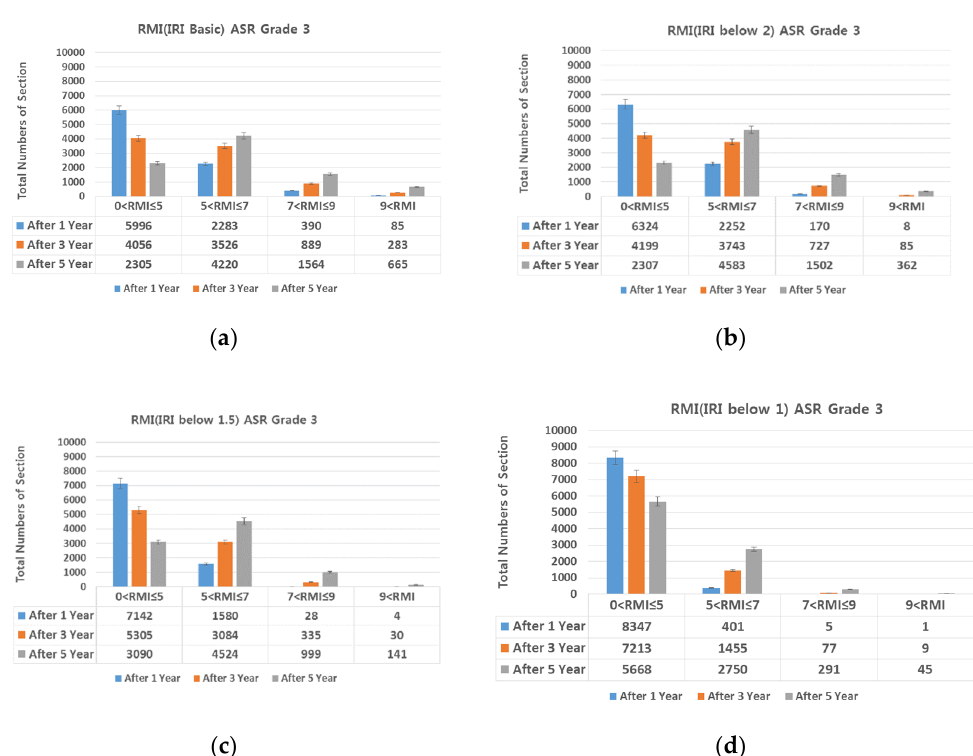
Figure 13. Change in number of sections per RMI with respect to IRI. ( a ) basic IRI and ASR grade 3; ( b ) IRI 2.0 and ASR grade 3; ( c ) IRI 1.5 and ASR grade 3; and ( d ) IRI 1 and ASR grade 3.